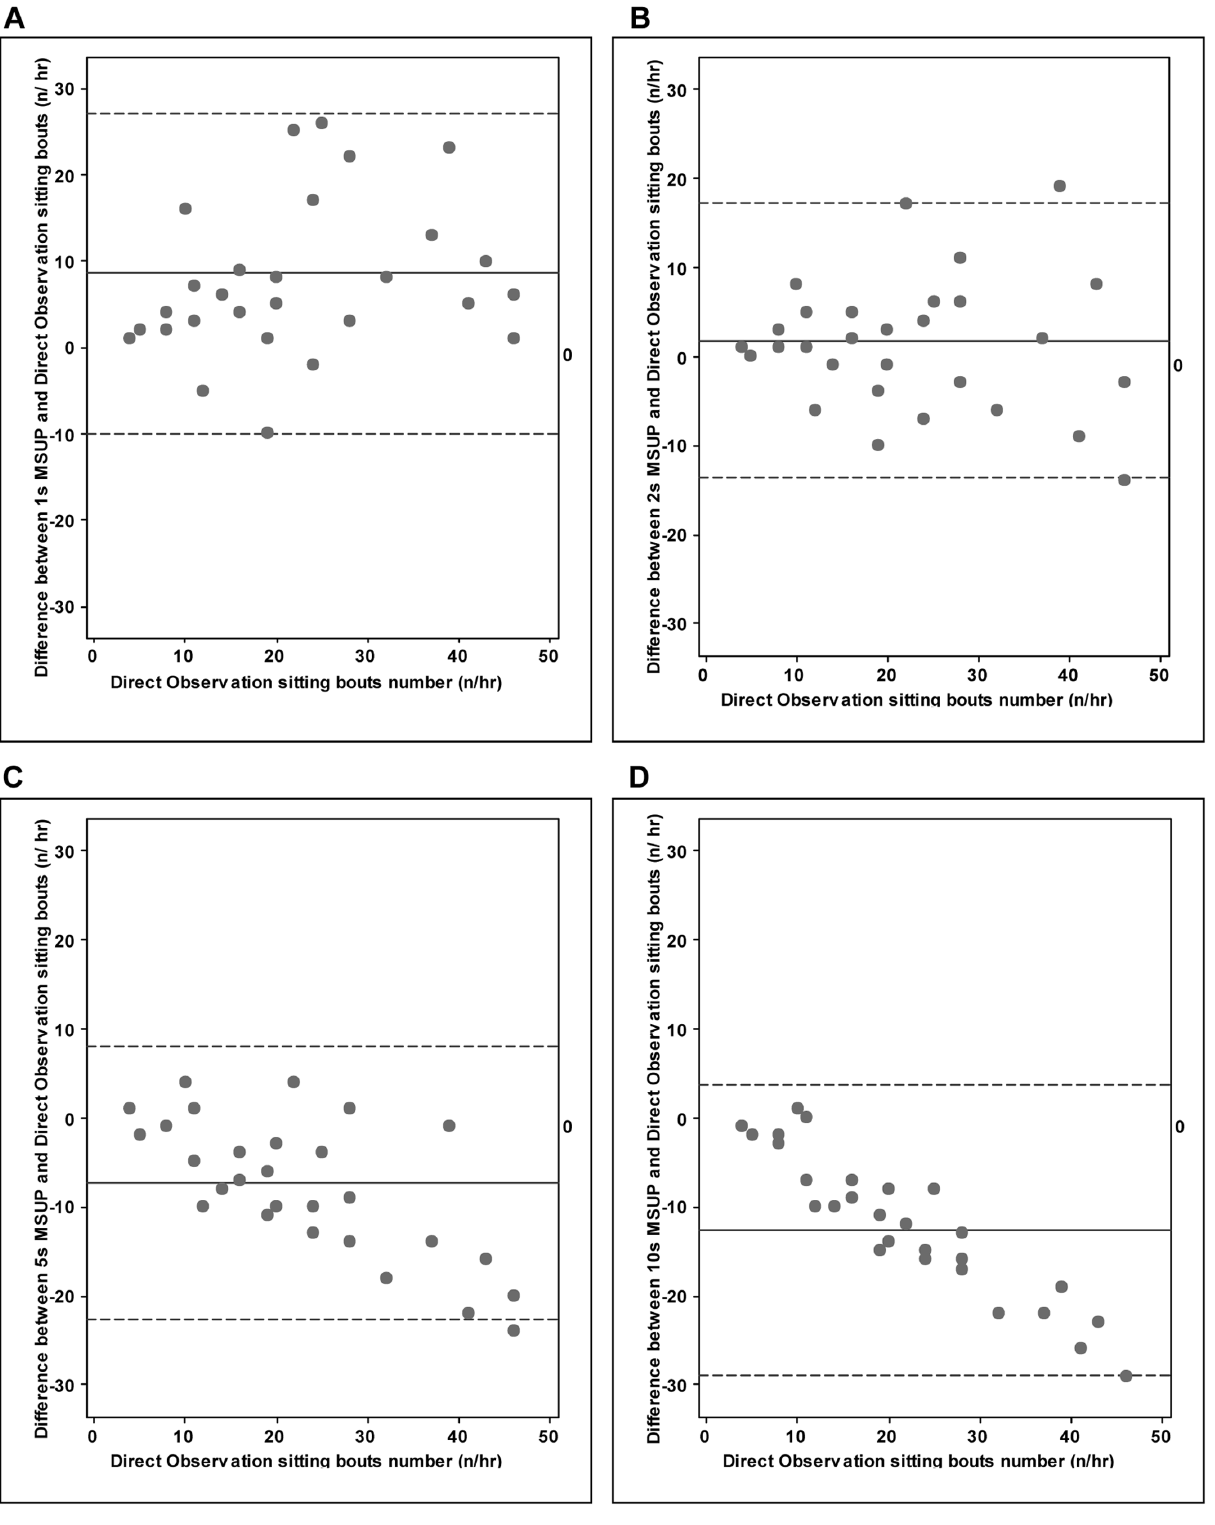
Figure 2. Individual Bland-Altman plots comparing the difference in number of sitting bouts during direct video observation (direct observation) with the number of sittings bouts measured by the activPAL TM with different activPAL TM settings for minimum sitting/upright period (1s – diff1 (A), 2s – diff2 (B), 5s - diff5 (C) and 10s - diff10s (D)). Study 2 (n=30). Data for 1 s taken from Davies et al [15]. Direct Observation is considered the criterion or gold-standard and it is used on the x-axis. Mean bias is represented by a solid line, 95% limits of agreement by dashed lines.